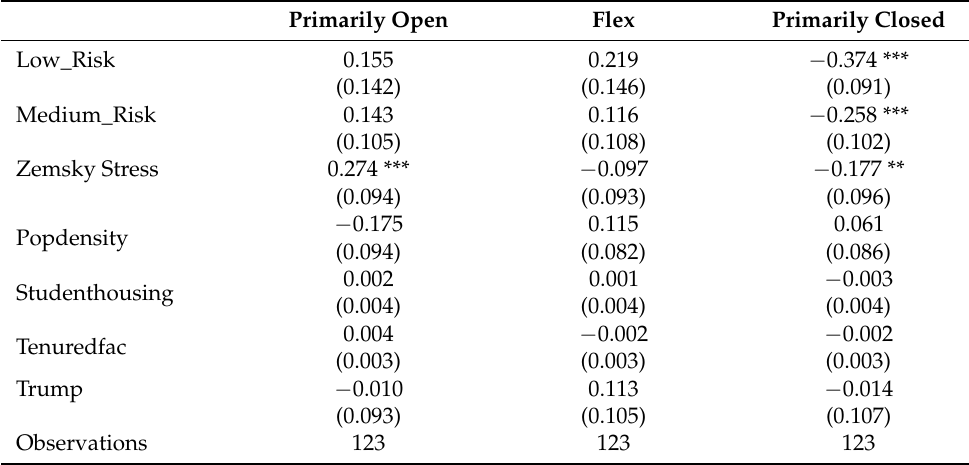
Table 5. Multinomial Probit Models Using the Zemsky Index (Marginal Effects).